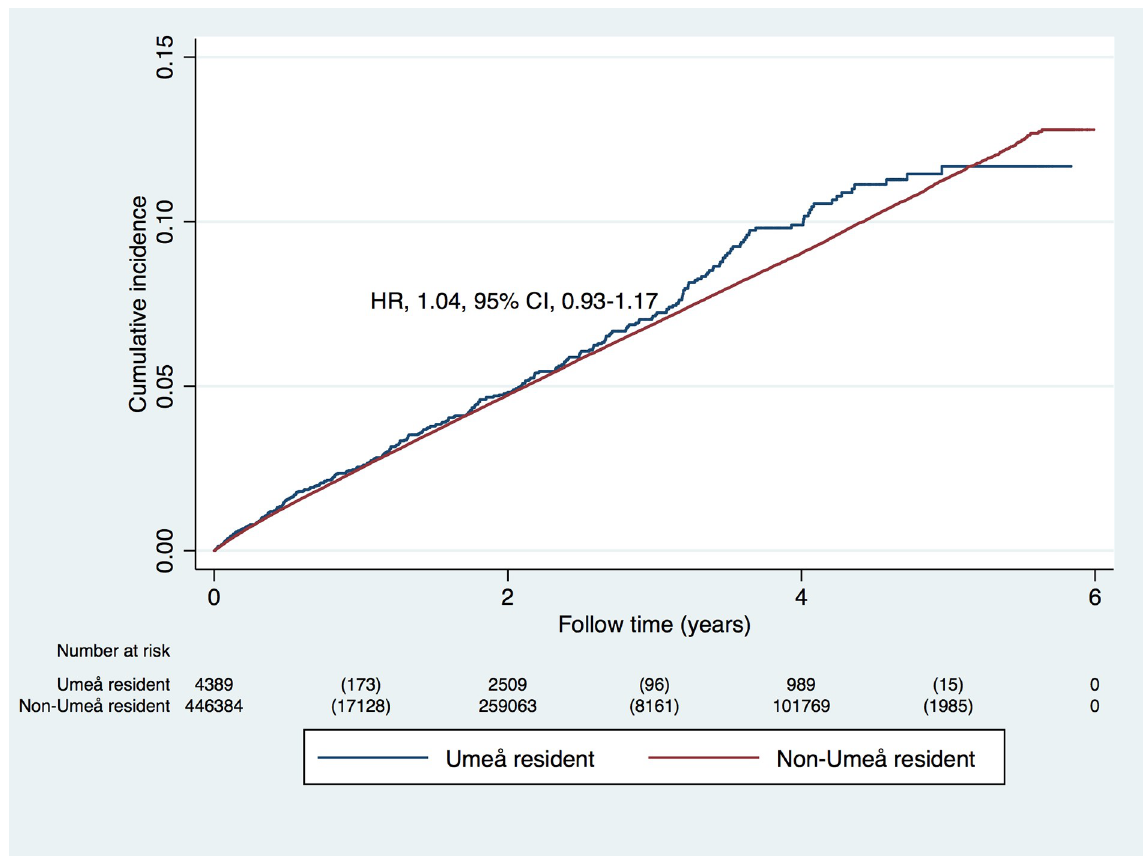
Fig 2. Risk of stroke, myocardial infarction, or angina pectoris in 70-year-old Ume å residents and in 70-year-olds from the rest of Sweden with baseline date in 2006–2011. The hazard ratio (HR) is presented for time to first outcome, and below the figure the number at risk at each time point is presented, together with the number of outcome events within